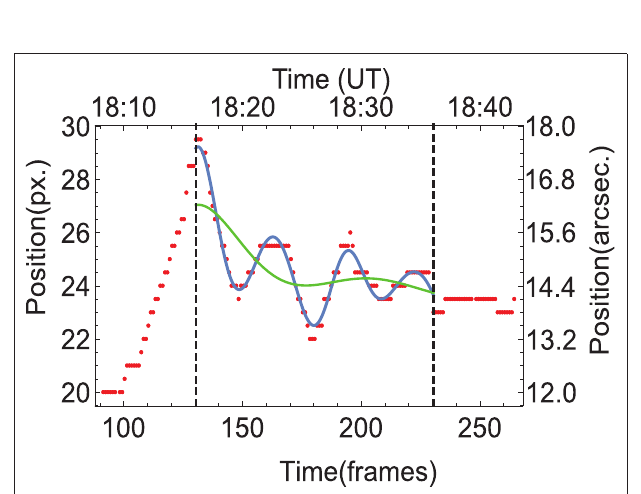
FIGURE 3 | Zoomed time-space diagram from Figure 2 with the Canny edge-detection output (blue lines) and the returned oscillation profile (red line) over-laid. The returned oscillation is qualitatively similar to the oscillation returned by Pascoe et al. (2016) for the same event.